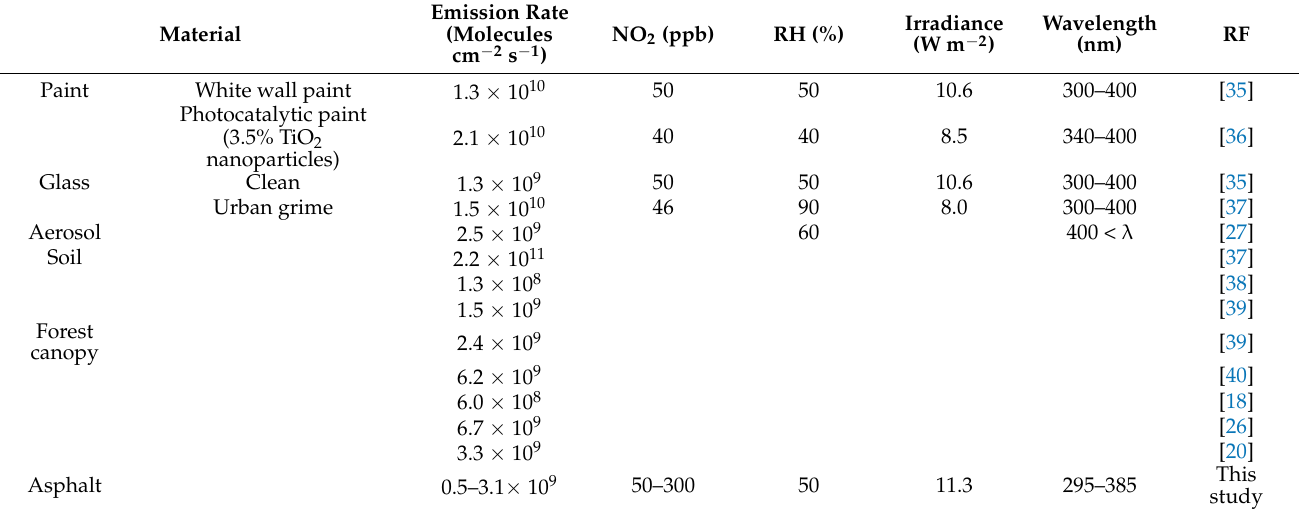
Table 1. Comparison of HONO emission rate on surfaces of various